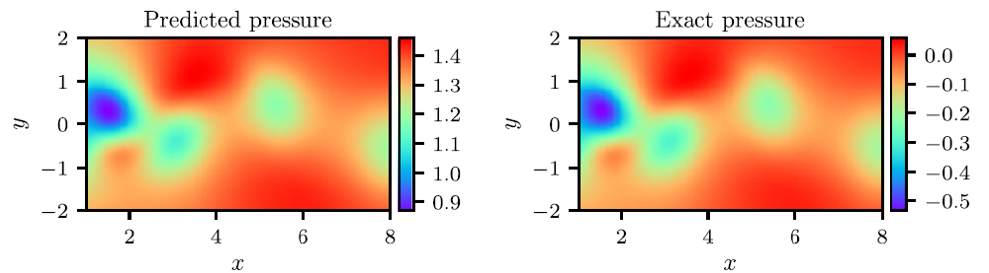
Figure 11. Instantaneous static pressure in the vortex shedding region downstream of circular cylinder. Reproduced with permission from [120]. Copyright 2018 Elsevier